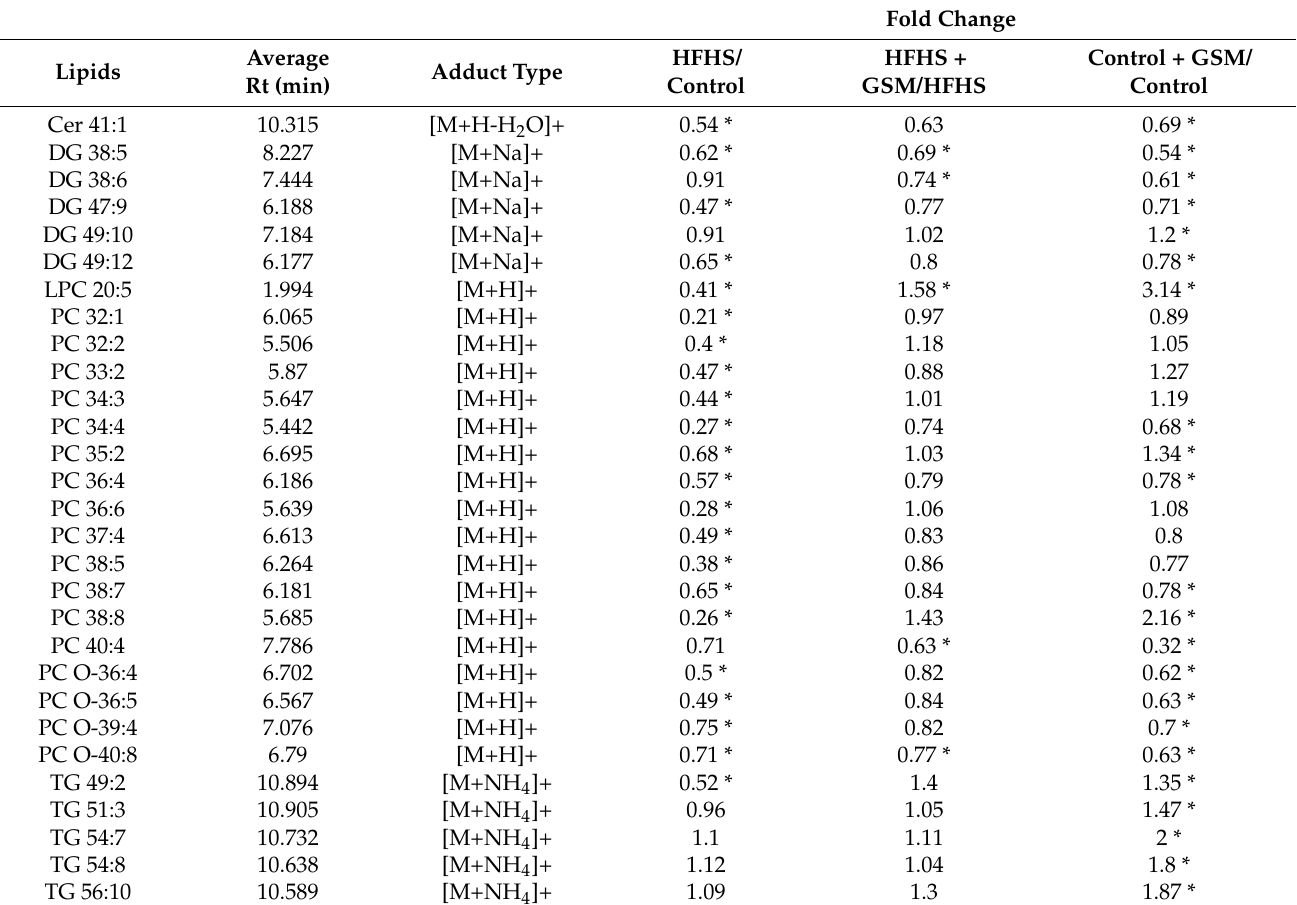
Table 2. Plasma lipid biomarkers affected by the HFHS diet or GSM treatment in sham rats.